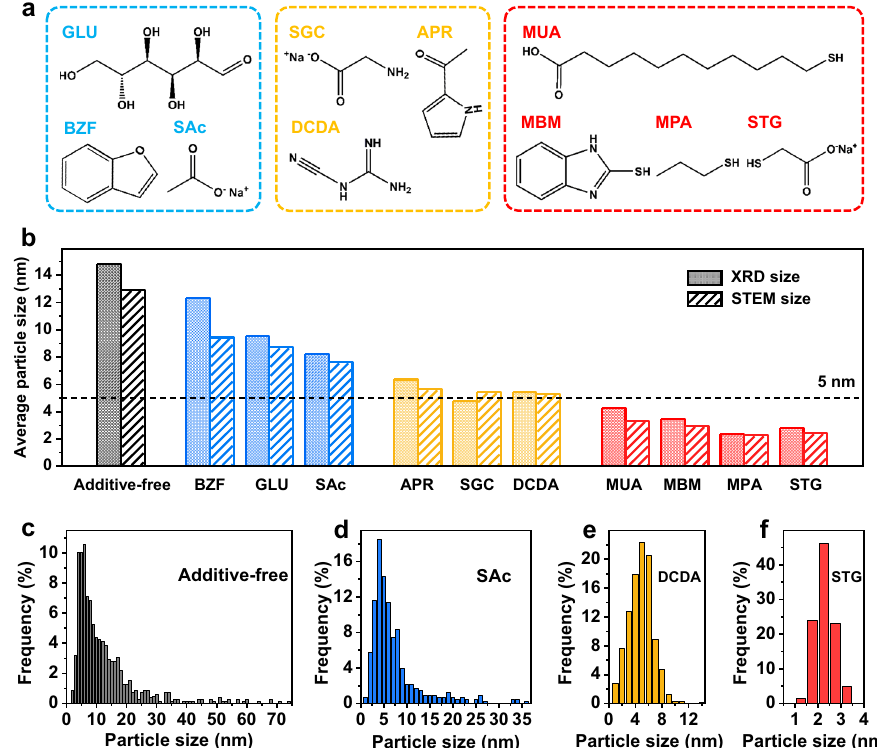
Fig. 1 | Screening small molecules for suppressing metal sintering. a The structures of the molecules used as additives for suppressing metal sintering. b XRD (solid shadow column) and STEM (twill stripes column) sizes of PtCo